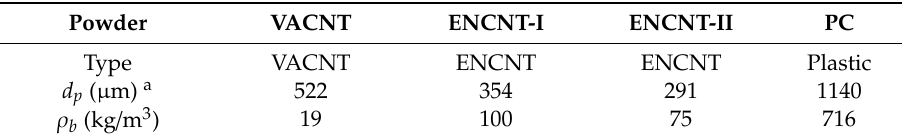
Table 1. Physical properties of particles used in experiment.